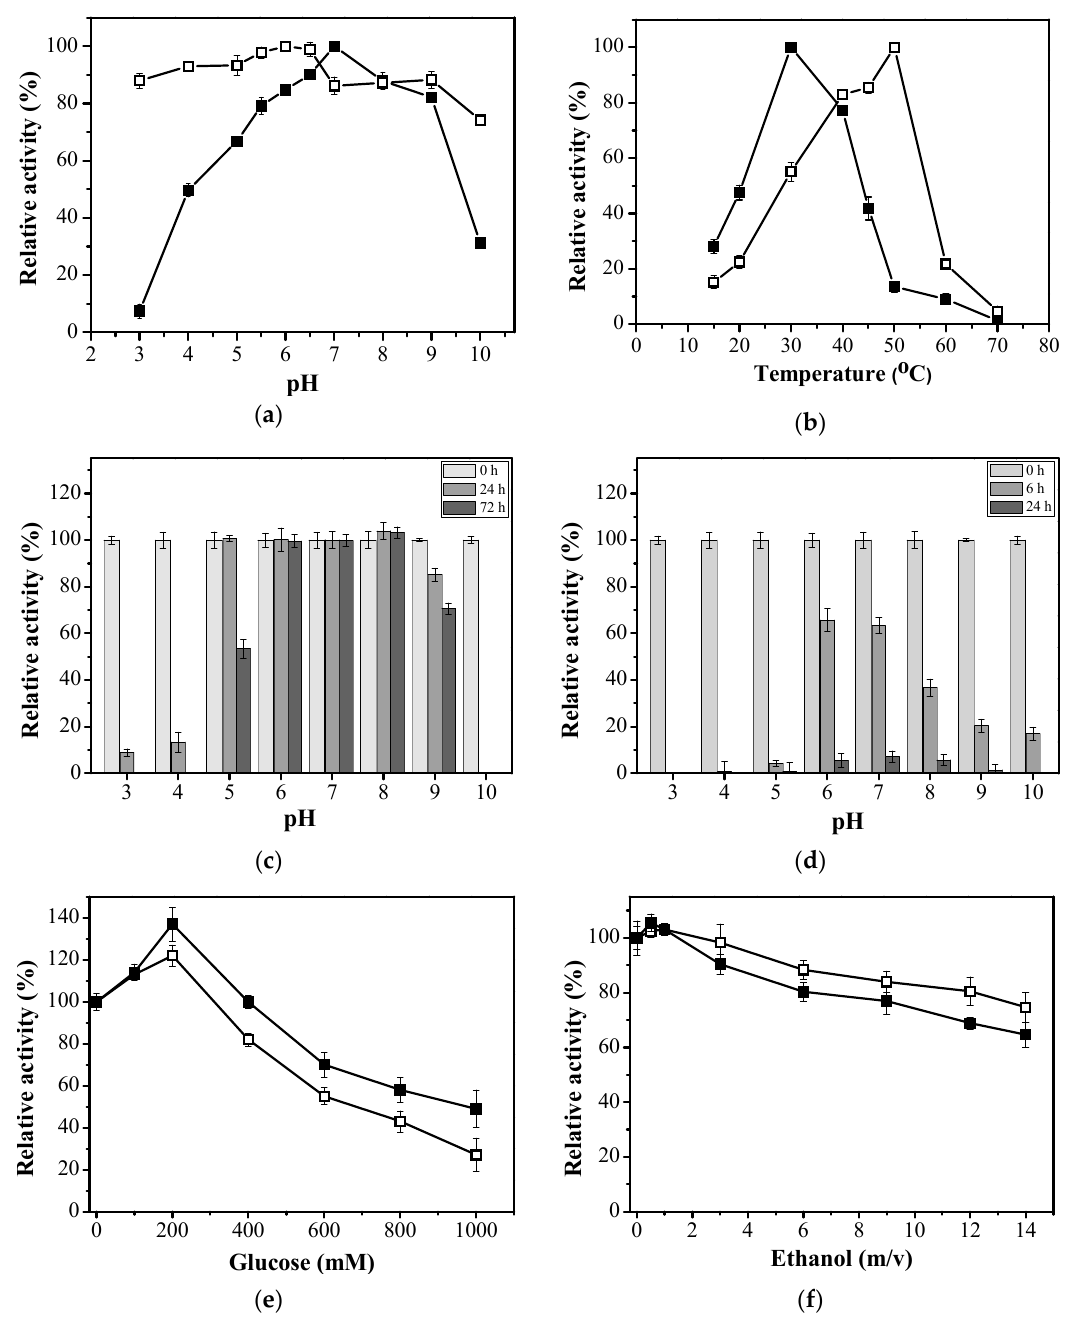
Figure 1. Functional analysis of free Ea BglA (filled squares) and agarose-GLU-IDA-Co 2+ - Ea BglA-PEI (empty squares); ( a ) Effect of pH and, ( b ) temperature on the enzymatic activity. pH-stability under different pH values; ( c ) agarose-GLU-IDA-Co 2+ - Ea BglA-PEI and ( d ) free Ea BglA. ( e ) The effect of glucose (0–1500 mM) and, ( f ) ethanol (0–14%, v/v ) on BGL activity. All enzymatic properties were determined using p NPG as substrate. All measurements were done in triplicates. Error bars show SD. The initial activities were regarded as 100% and relative activities were expressed as a percentage of initial activity.